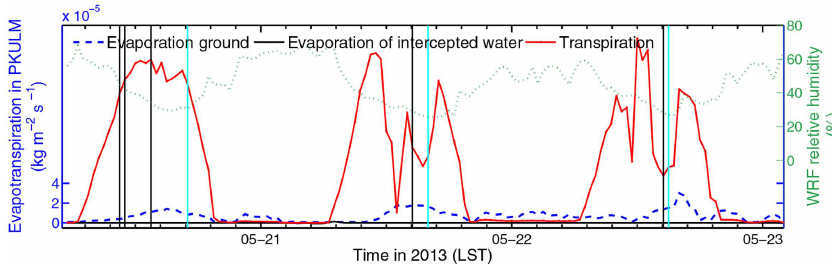
Fig 8. Evapotranspiration rate simulated by PKULM, including ground Evaporation, evaporation of water incepted by canopy, and transpiration of canopy in 2013 (left axis). In-situ WRF relative humidity (right axis). The black meridional lines indicate the time when skin temperature peaks while the cyan lines indicate the time when in-situ observed 2 m temperature peaks.